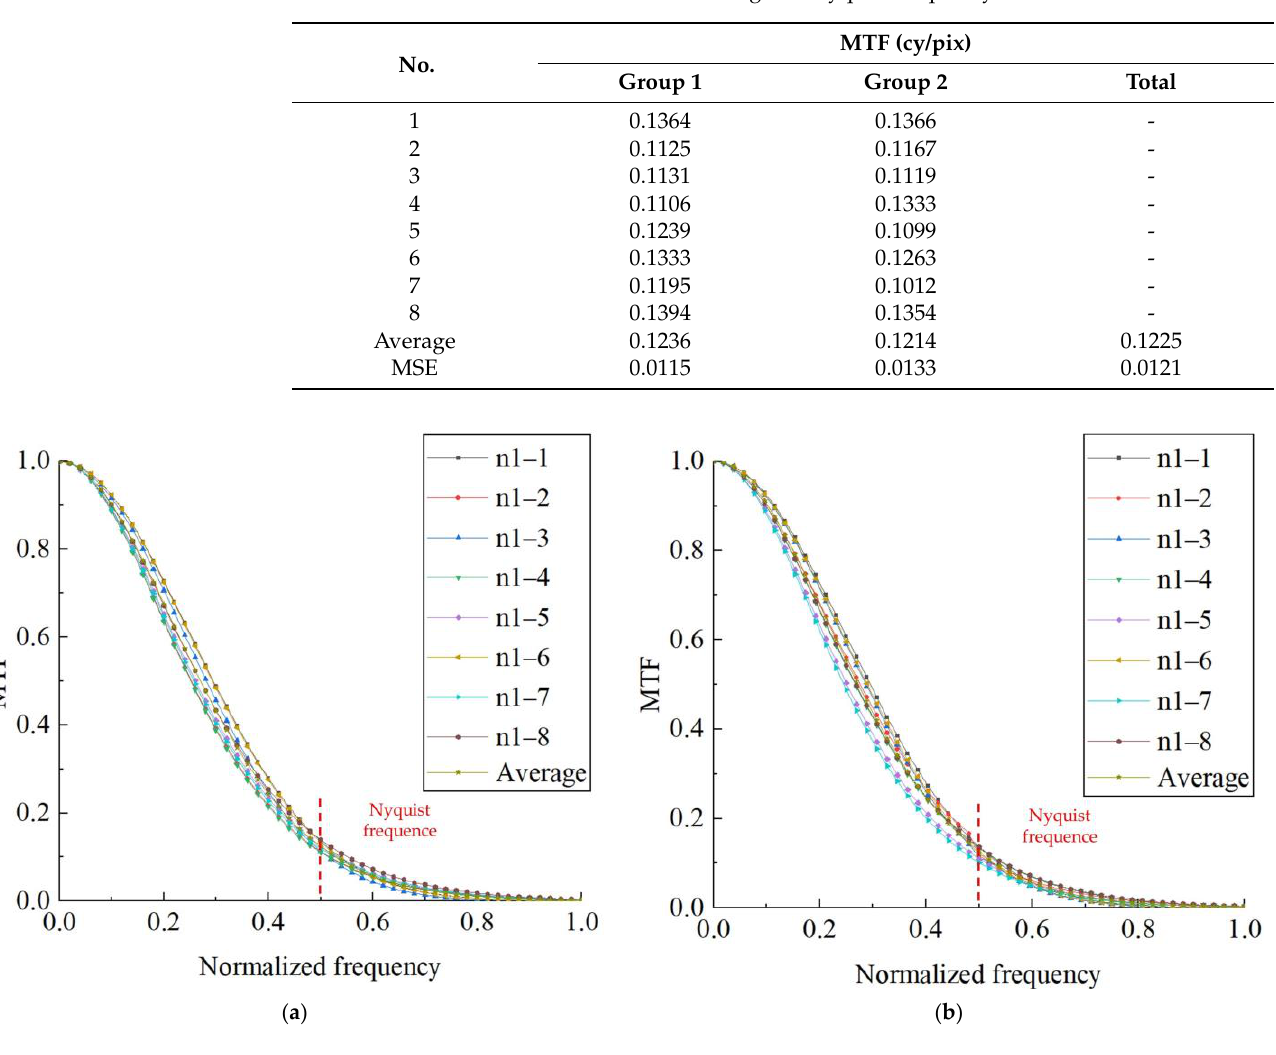
Table 4. MTF calculated from the radiation target at Nyquist frequency.